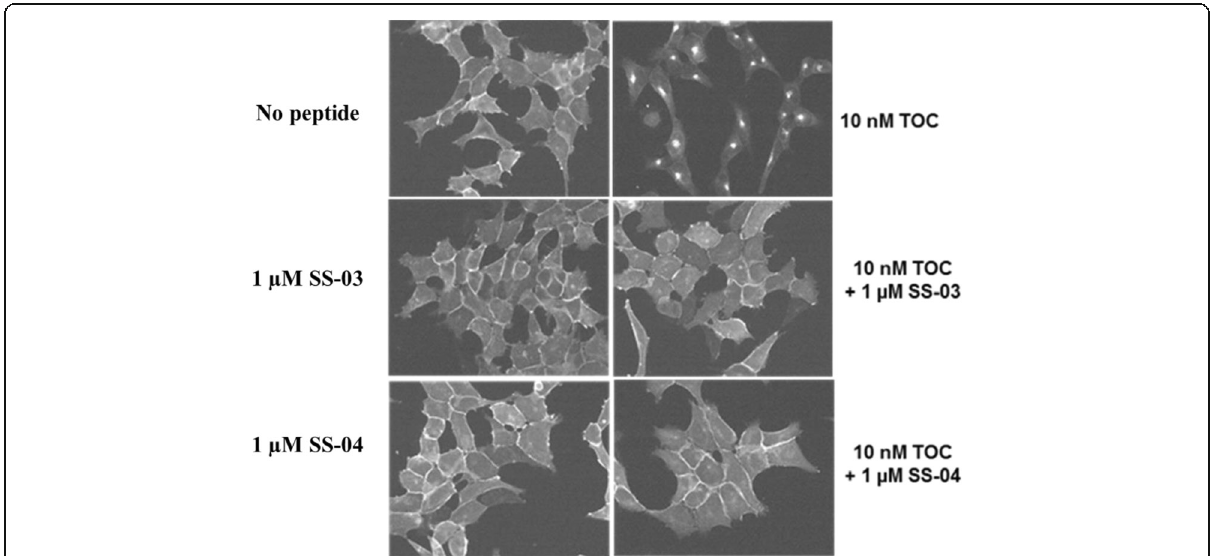
Fig. 2 Immunofluorescence microscopy-based internalisation assay on HEK-sst2 cells. Immunofluorescence microscopy-based internalisation assay with HEK-sst2 cells showing the sst2 internalisation induced by [Tyr 3 ]octreotide (TOC) is efficiently antagonised by SS-03 and SS-04. Control experiment showing membrane bound sst2-receptor in the absence of peptide. The agonist, TOC, triggered massive sst2-receptor internalisation at a concentration of 10 nM. The antagonists SS-03 and SS-04 failed to induce sst2 internalisation even at a concentration of 1 μ M. Further, both SS-03 and SS-04 at a concentration of 1 μ M efficiently blocked the agonist (TOC, 10 nM)-mediated sst2-receptor